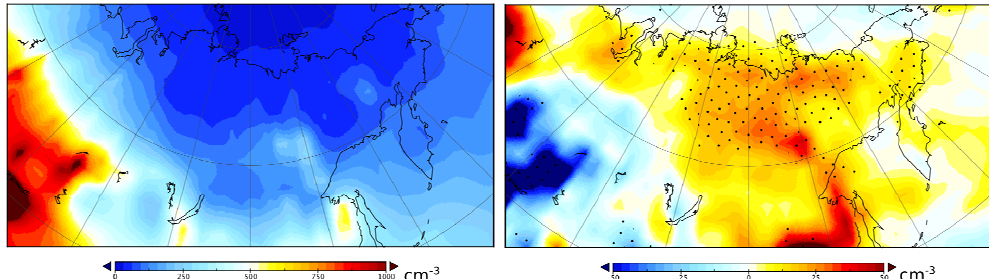
Figure 3. Annual average boundary-layer CCN (1.0%) concentration (cm − 3 ) in Siberia with present-day anthropogenic and BVOCs (for BNS: E ∗ = 1 . 9) emissions (left panel), and changes in CCN (1.0%; right panel) concentration due to increase in BVOC emission between years 2000 and 2100 (simulations with CO 2 inhibition off). Areas with statistical significant changes in CCN are indicated by dots. The statistical analysis is based on monthly average CCN concentrations from 5 years of simulated data, and statistical significance of the CCN anomaly is evaluated using a two-sample t test, without assuming equal variance between the two